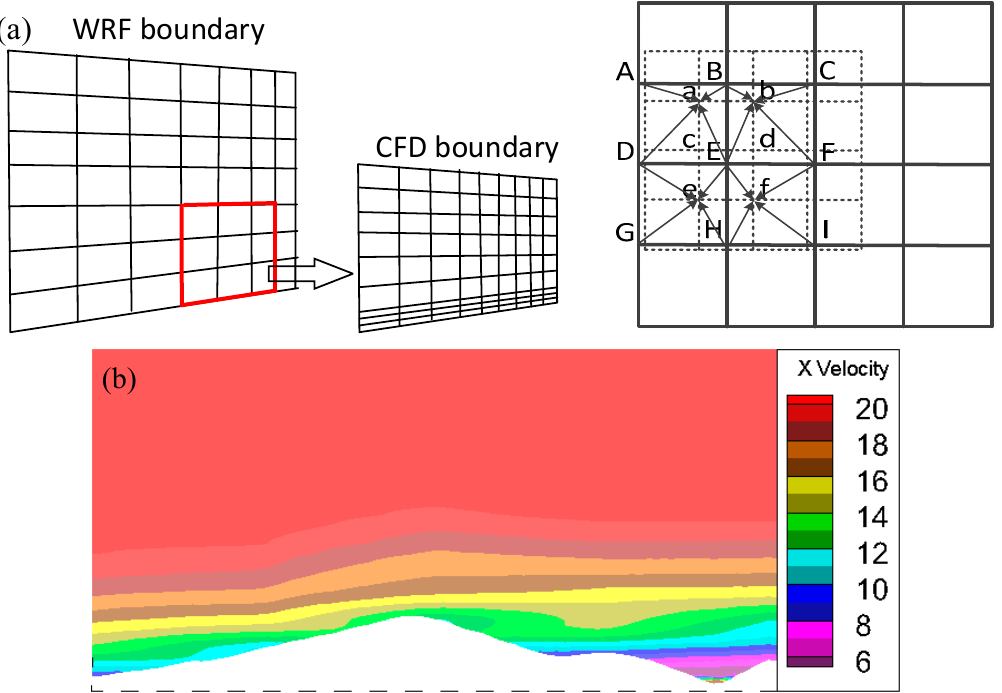
Figure 5. Cressman interpolation coupling method: ( a ) Diagram of imposing the WRF wind data on a